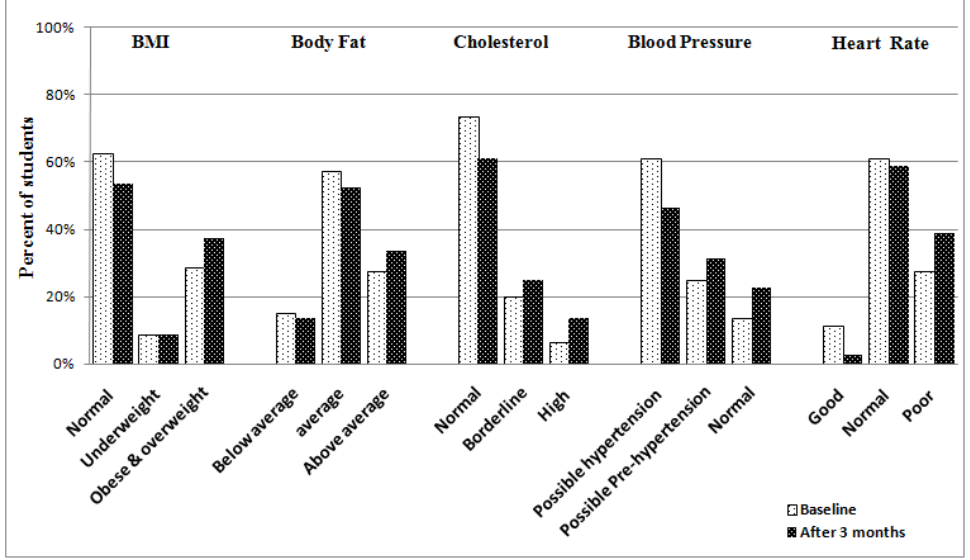
Figure 5. Anthropometric and physiological parameters of control pupils after 3